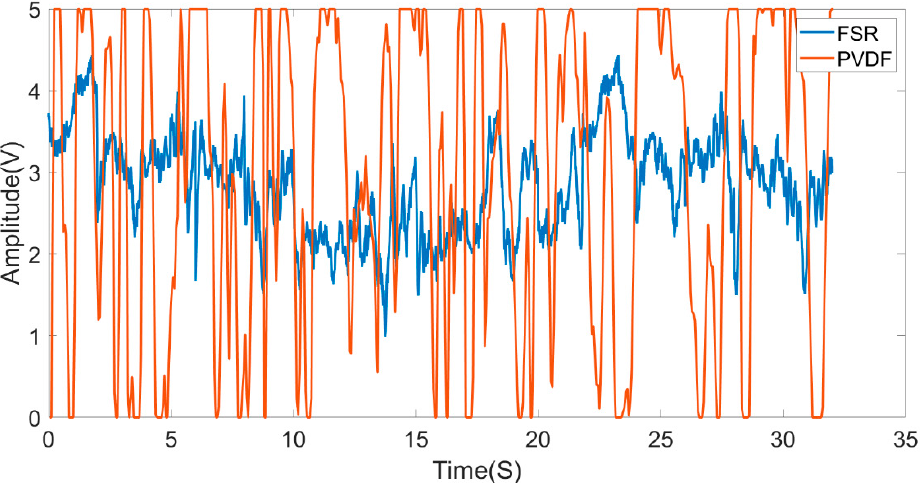
Figure 18. The output of the FSR system (blue line) and PVDF system (red line).